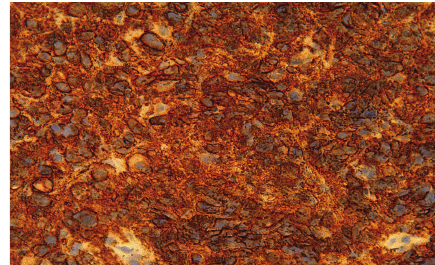
Figure 5: CD20 40x. Mediastinal large B-cell lymphoma biopsy CD20 40x.